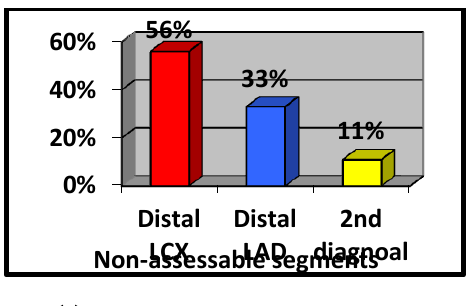
Fig. (4): P atients history regarding CAD, diabetes mellitus (D.M), hypertension and smoking.